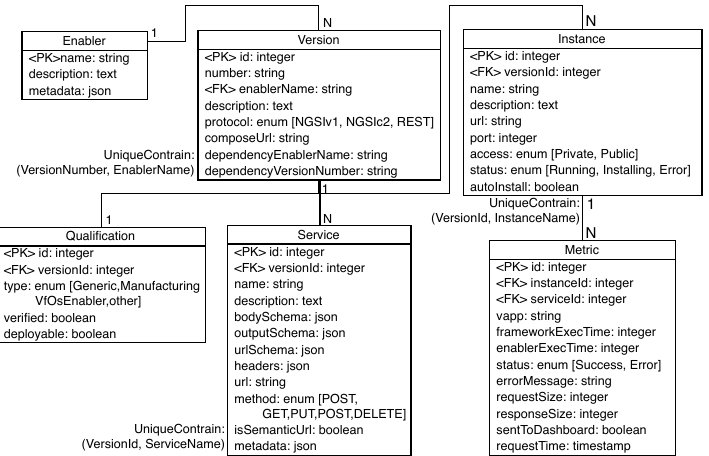
Figure 4. Enabler data structure class names and their relations. Attributes and parameters are not presented in order to simplify the